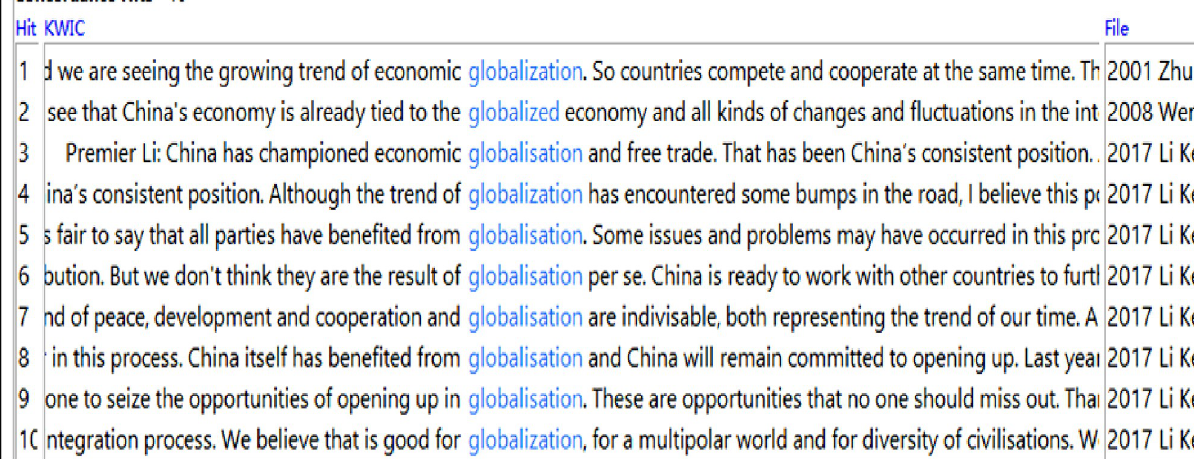
Fig 5. Screenshot of concordance lines featuring globalis * (by year).